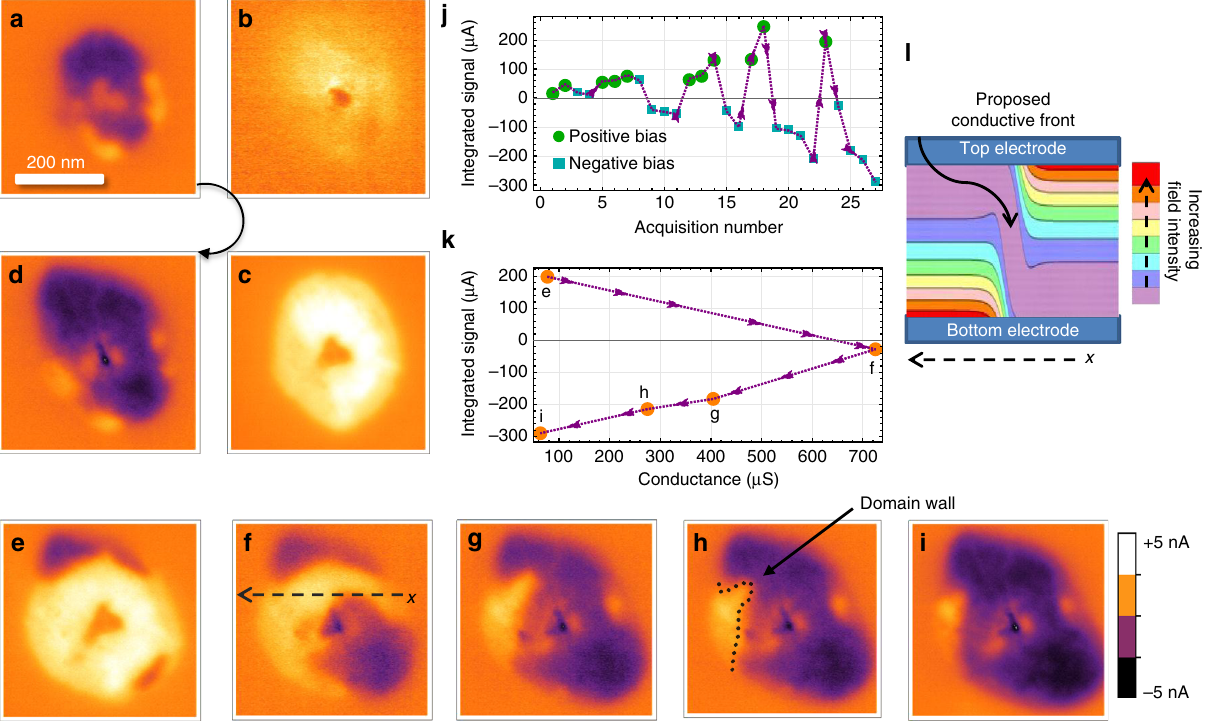
Fig. 10 Reversible electron – hole signals in symmetric device. a – d 5 keV electron beam-induced current (EBIC) images of alternating hard changes in polarization observed in symmetric devices. The sign of the measured current is changing since the device built-in fi eld is changing direction as a consequence of programming. e – i Gradual movement of a domain wall around a barrier to encompass the entire switching region. j Plot of effect of programming bias on device polarization with increasing amplitude of bias. k Relationship between total EBIC signal and conductance (at 0.1 V) from stepwise transition from e to i . l Cartoon depiction of the polarization domains with a reversal in fi eld concentration from the top electrode to the bottom electrode with